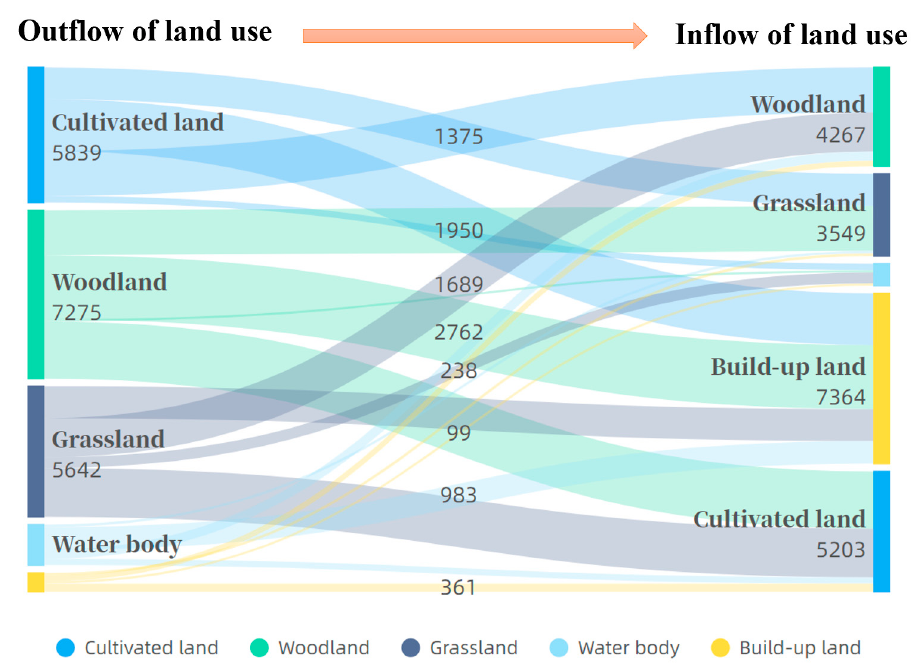
Figure 7. Sankey map of land-use change transfer from 2020 to 2030.